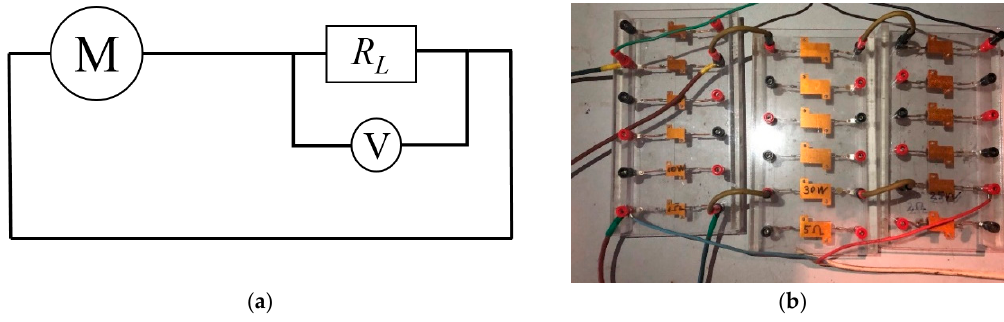
Figure 6. Voltage acquisition system: ( a ) contained circuit diagram; ( b ) connection resistances diagram.